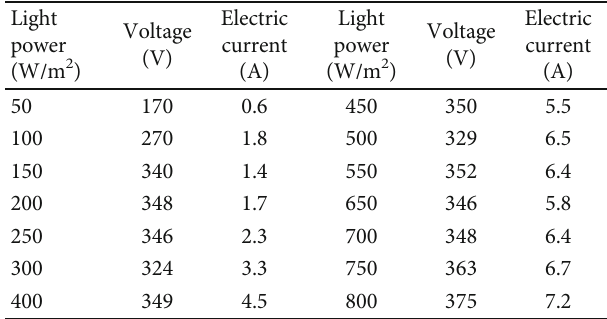
Table 3: Output voltage and current data of maximum power point under di ff erent light